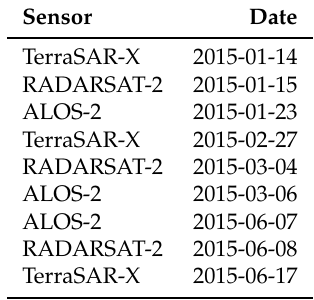
Table 1. SAR images included in wrapper analysis. TerraSAR-X data acquired as StripMap, RADARSAT-2 in Standard Beam mode, and ALOS-2 as Fine Beam StripMap, at 5m, 20m, and 10m targeted ground resolution,